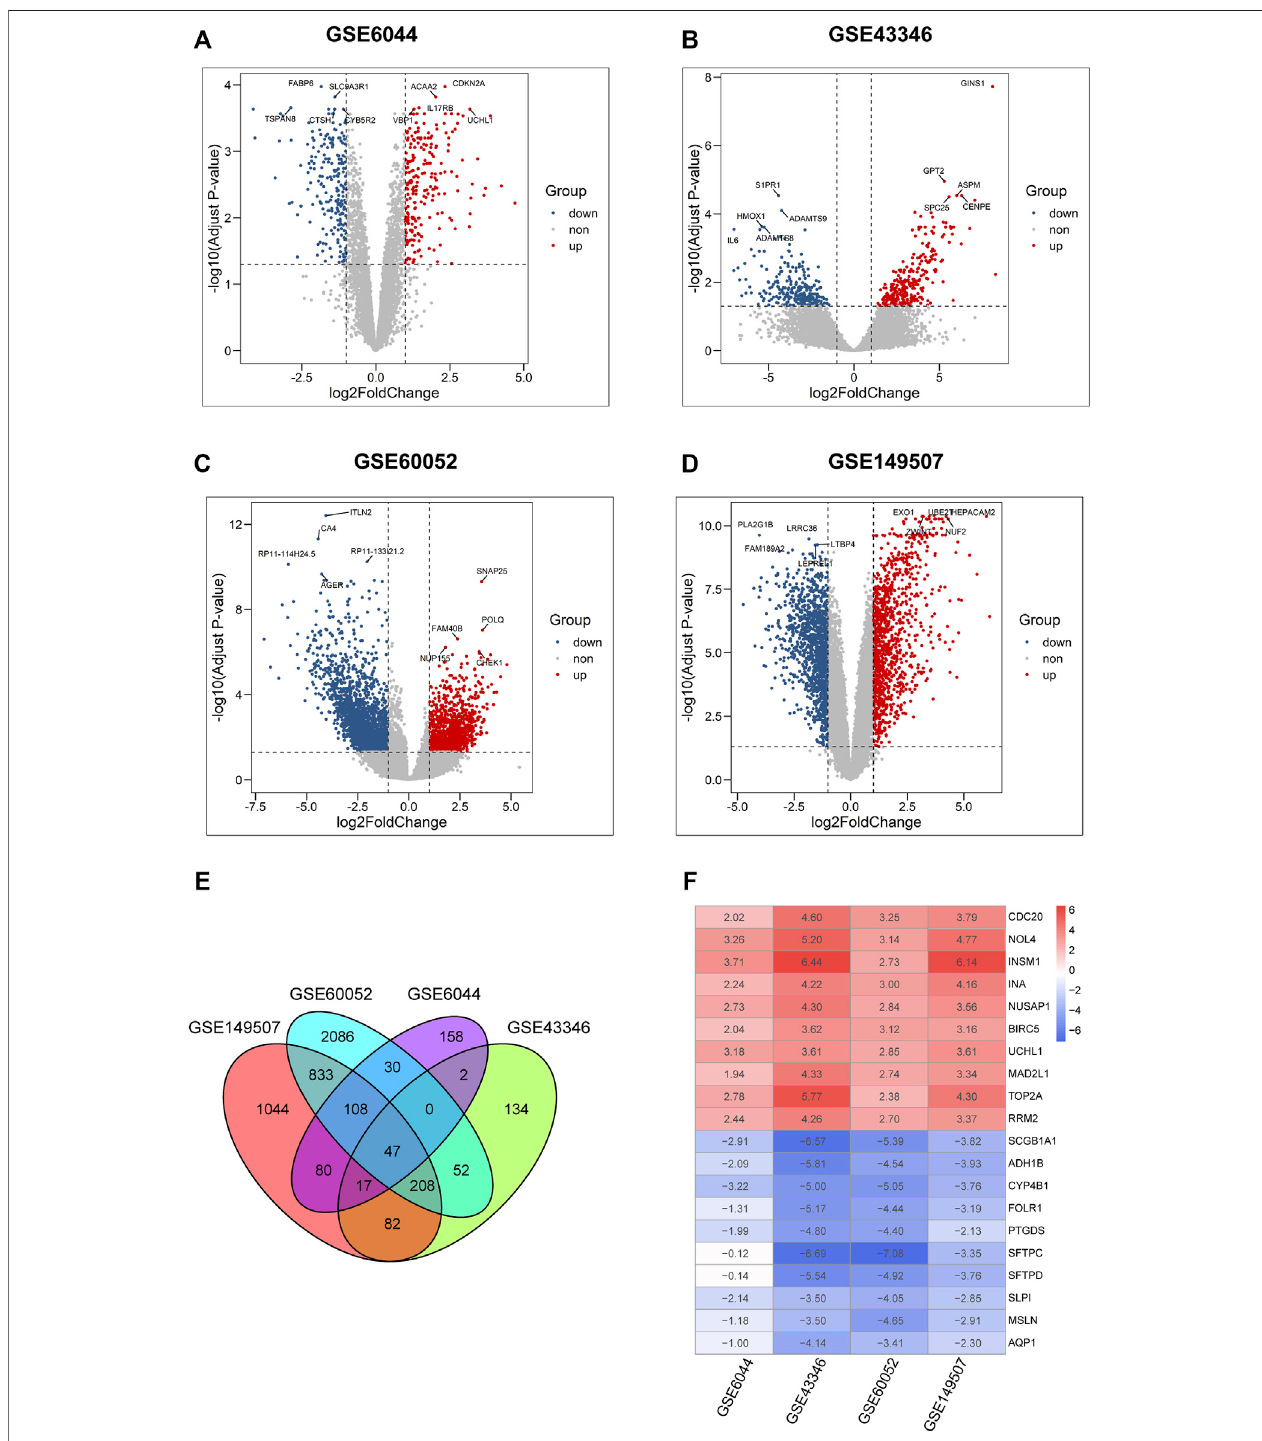
FIGURE 2 | Identi fi cation of DEGs in four microarray datasets from GEO. (A – D) Volcano plots of differential expression analysis for GSE6044, GSE43346, GSE60052, and GSE149507. Plots in red, blue, and gray represent upregulated, downregulated, and non-signi fi cant genes, respectively. (E) Venn diagram of the overlapped differential expressed genes in four GSE datasets. (F) Expression heatmap of top 10 up- and down-regulated genes, each column in the table represents a Log2FC value calculated for each gene.